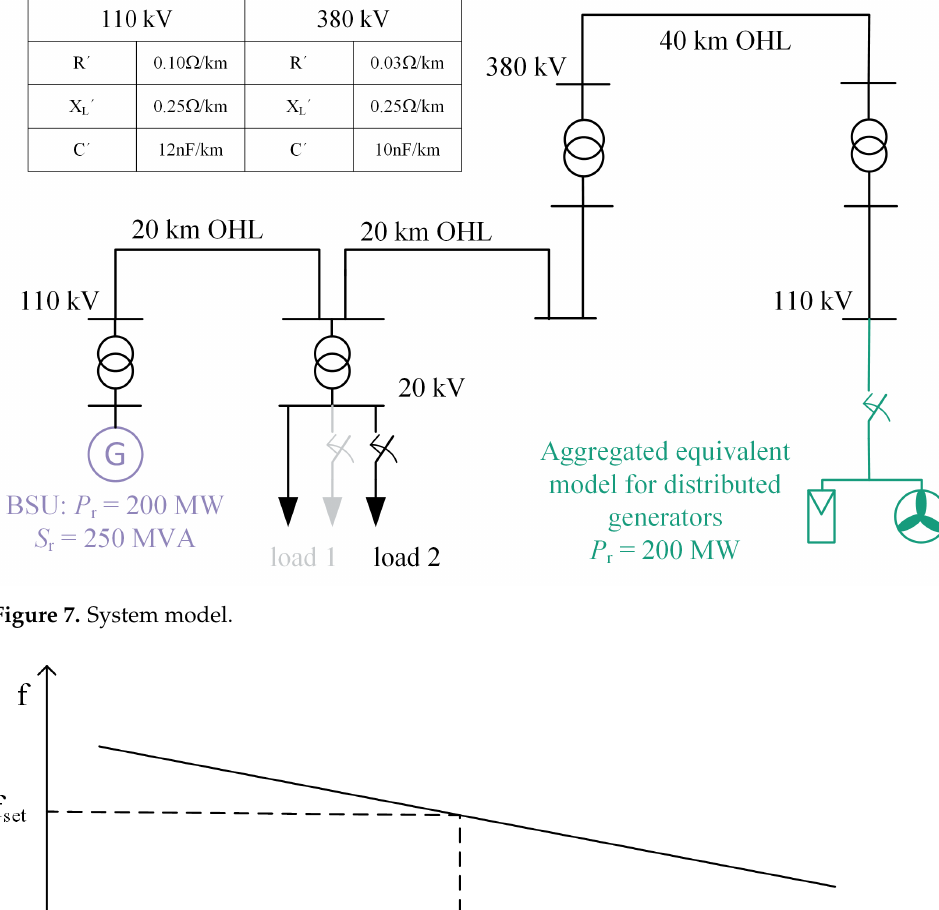
Figure 8. Droop curve of the power